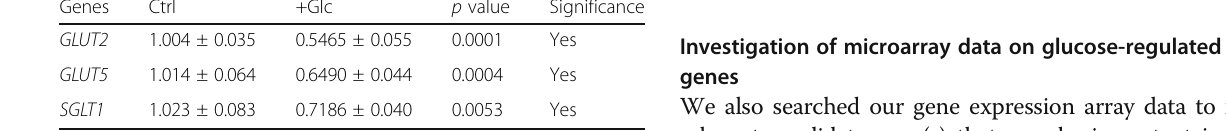
2: Table S2 and Additional file 3: Table S3). These genes were used to identify high glucose-regulated molecular pathways by DAVID bioinformatics program using KEGG Pathways database. The gene IDs were converted to DA- VID gene IDs that were associated with particular pathway annotation terms. The enrichment of molecular pathways was performed by Benjamini-Hochberg method, and p ≤ 0.